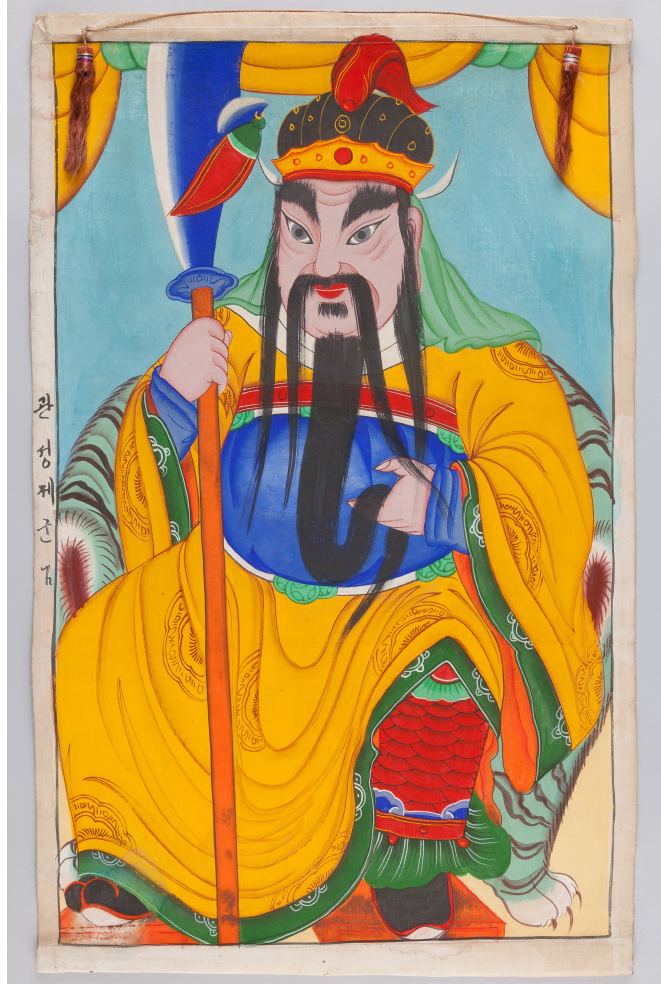
Figure 6. Hwang Ch’un‑sŏng. Emperor Guan (Kwansŏng chegundo 關聖帝君圖 ). Post‑1945, S. Korea. Colors on silk. 83.5 cm × 53 cm. National Folk Museum of Korea, Seoul (minsok 072639). Image Korea,